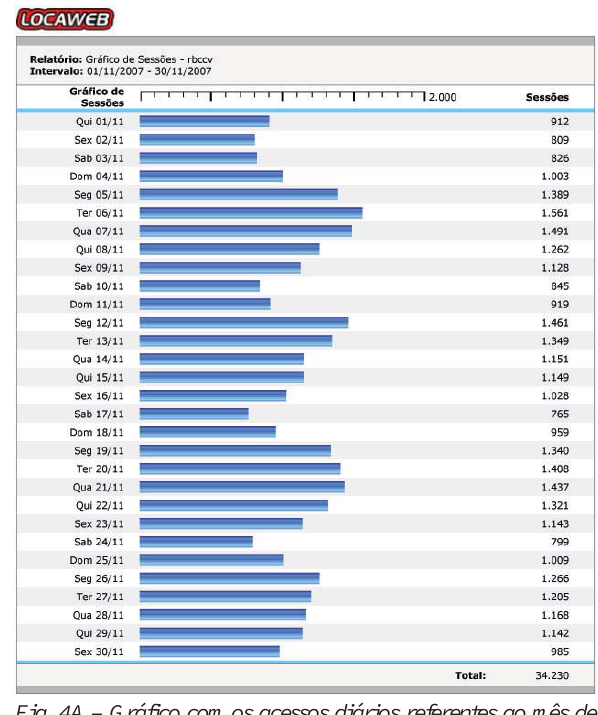
Fig. 4A – Gráfico com os acessos diários referentes ao mês de novembro de 2007 no site da RBCCV